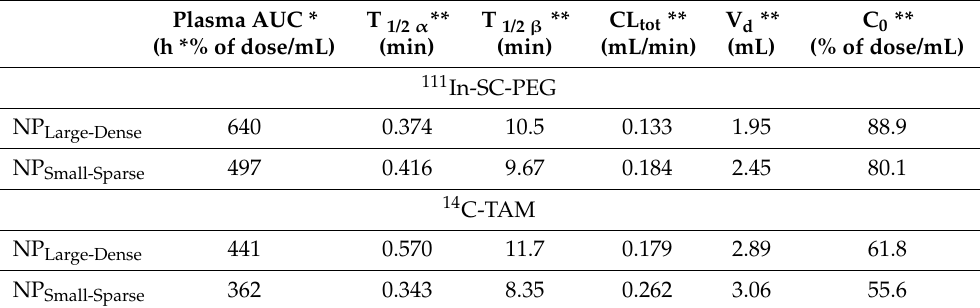
Figure 7. Pharmacokinetics and tissue distributions of 14 C-TAM-loaded 111 In-SC-PEG nanoparticles (NPs). Panels ( A – C ) show normalized plasma concentration, liver distributions, and spleen distributions of 111 In-SC-PEG NPs, respectively. Panels ( D – F ) show normalized plasma concentration, liver distributions, and spleen distributions of 14 C-TAM, respectively. Filled triangles and open squares indicate SC-PEG NPs prepared by LiBr 100 mM at a flow rate of 3 mL/min, and LiBr 20 mM at a flow rate of 8 mL/min, respectively. Solid lines and dashed lines in panels A and D, respectively, indicate two-compartment model fitted curves. Results are expressed as mean ± SD of three mice: * p < 0.05. Table 3. Pharmacokinetics parameters of PEG Small-Sparse NPs and PEG Large-Dense NPs. Plasma AUC